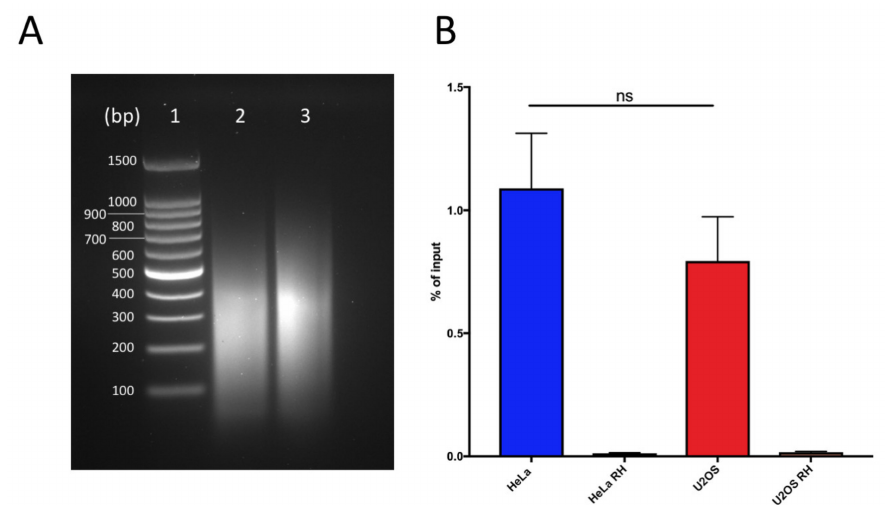
Figure 1. DNA:RNA immunoprecipitation successfully retrieves DNA:RNA hybrids: ( a ) Chromatin digestion profiles for HeLa (lane 2) and U2OS (lane 3). Lane 1 corresponds to DNA ladder 100 bp (Promega). ( b ) Quantification of DNA:RNA hybrids at RPL13 positive control locus in U2OS and HeLa cells as measured by qPCR. Bars and error bars are the averages and SEM of four experiments. p -values are calculated using one-way ANOVA (ns, not